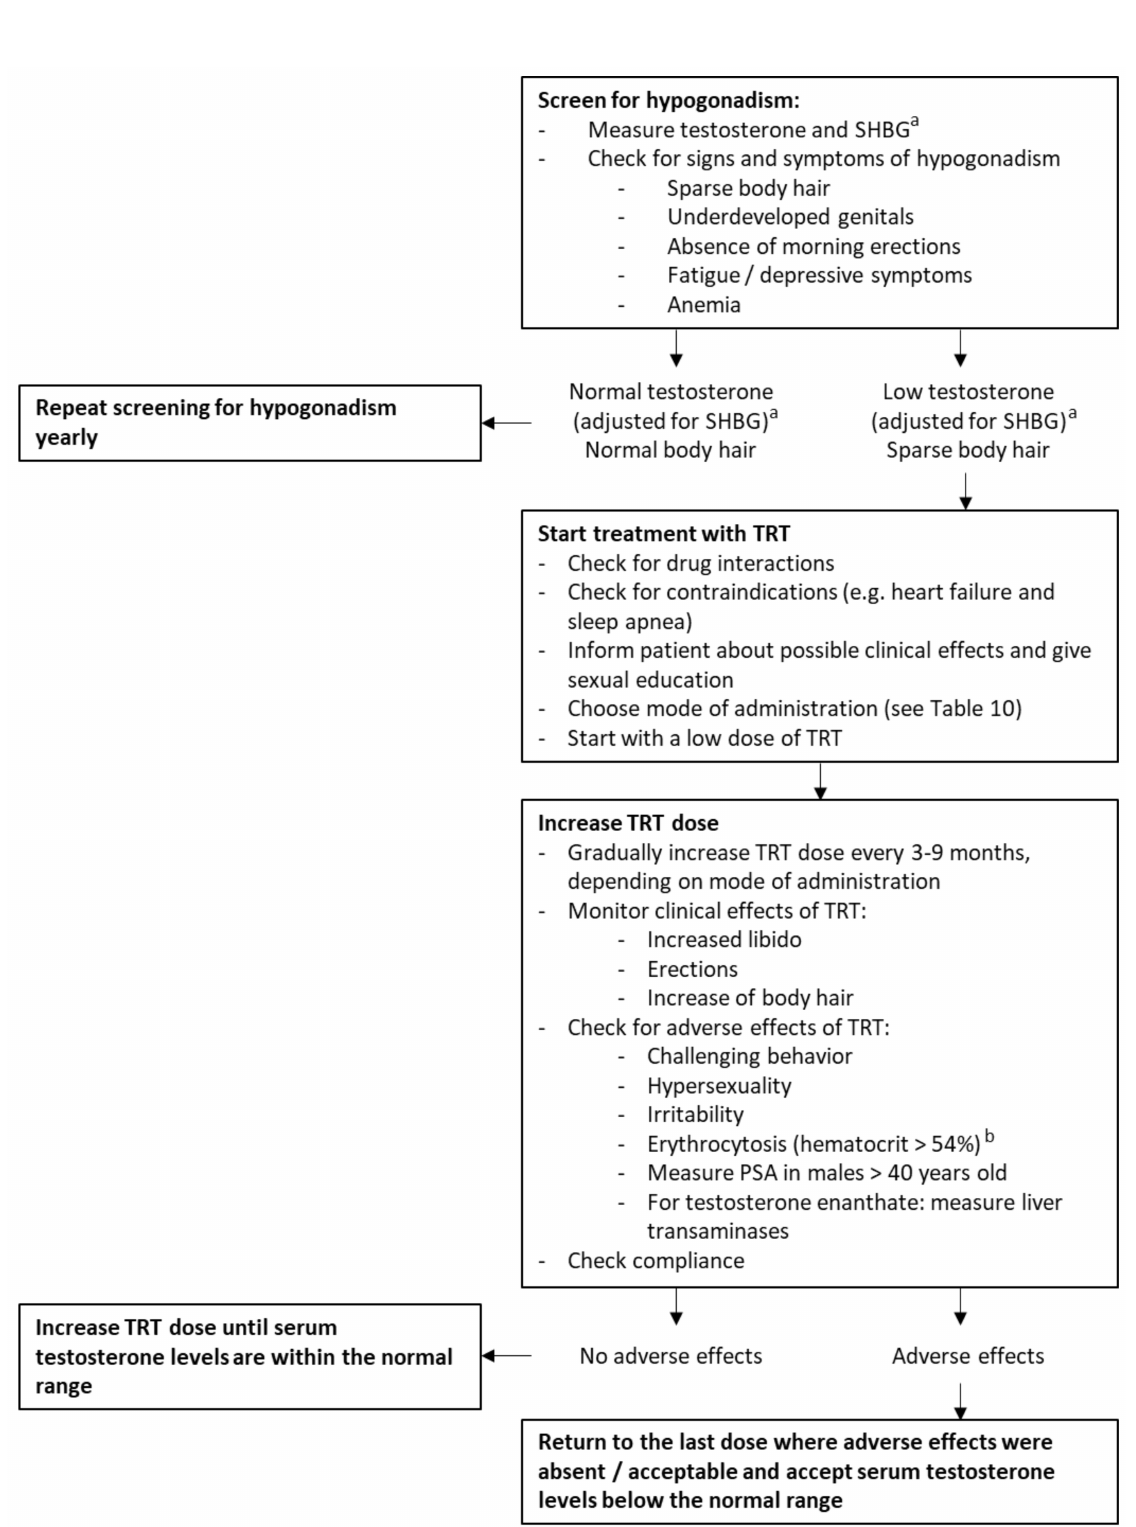
Figure 6. Recommendations for hypogonadism in adult males with PWS. Abbreviations: sex hormone binding globulin (SHBG), testosterone replacement therapy (TRT). a Instead of total testosterone and SHBG, free testosterone can also be measured to diagnose hypogonadism in males with PWS. b Based on the Endocrine Society Clinical Practice Guideline for testosterone therapy in men with hypogonadism